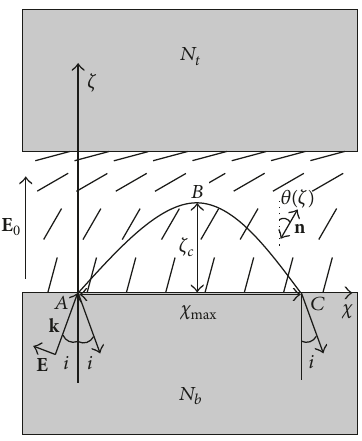
Figure 1: Illustration of a pure thermotropic nematic confined between two parallel substrates. A 𝑃 -polarized mode is traveling along the hybrid nematic. 𝑁 𝑏 , 𝑁 𝑡 > 𝑛 ‖ ,𝑛 ⊥ . The trajectory of the beam shows a caustic. 𝜁 𝑐 is the ray penetration. We introduced the dimensionless variables 𝜁 ≡ 𝑧/𝑙 and 𝜒 ≡ 𝑥/𝑙